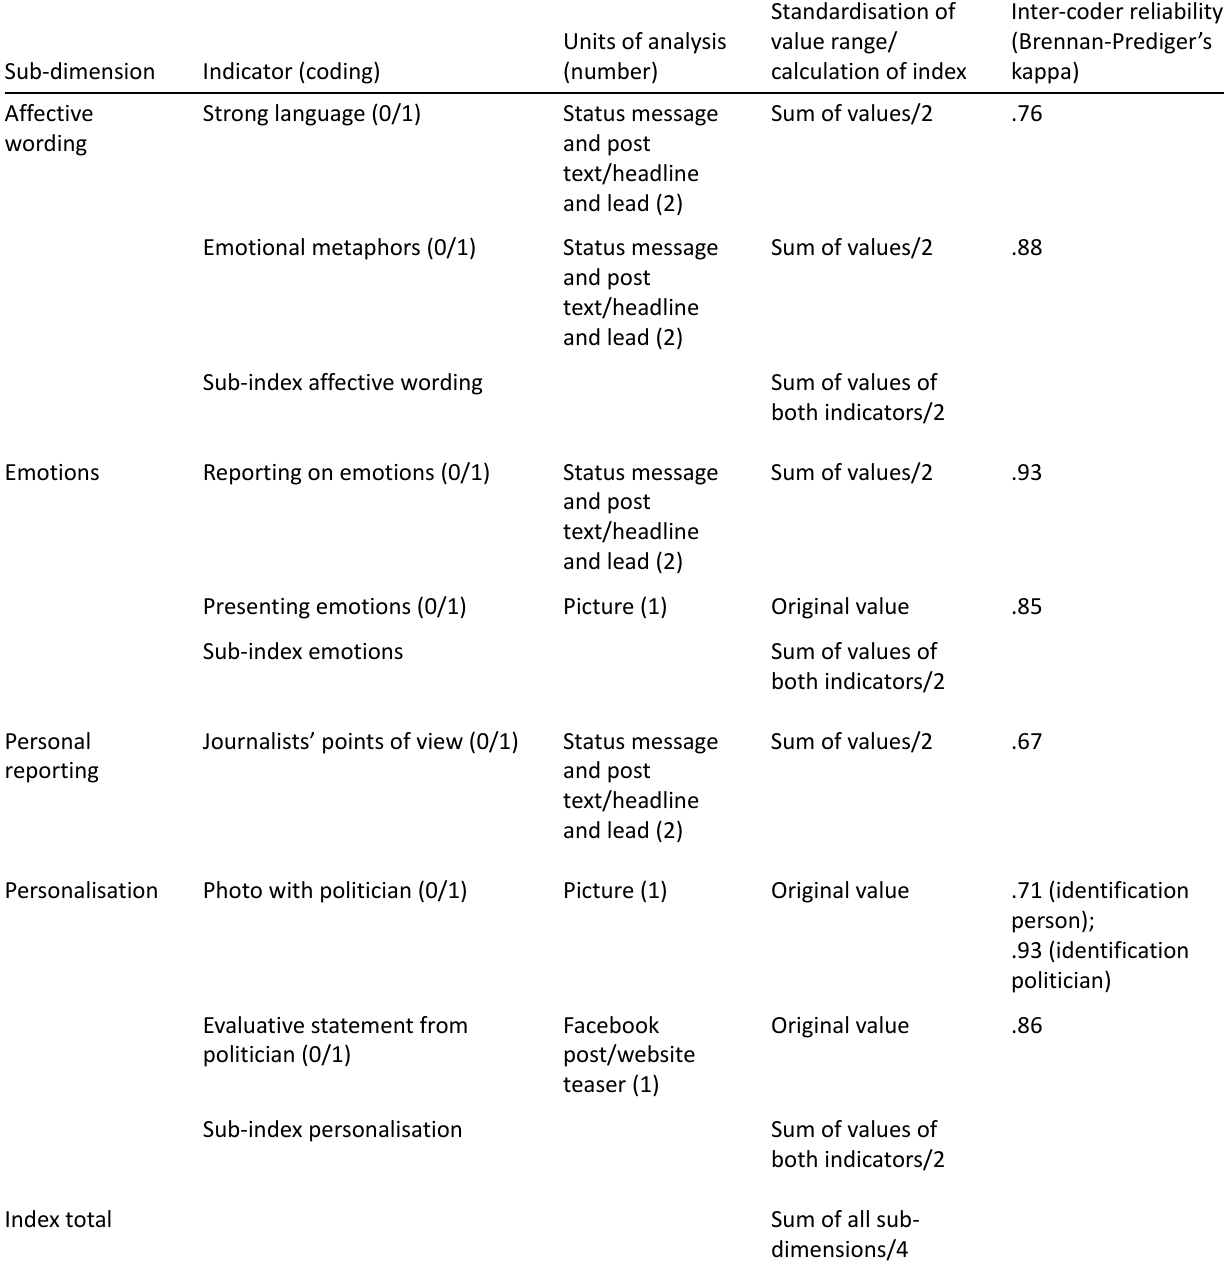
Table 1. Overview of sub-dimensions and the measurement of related